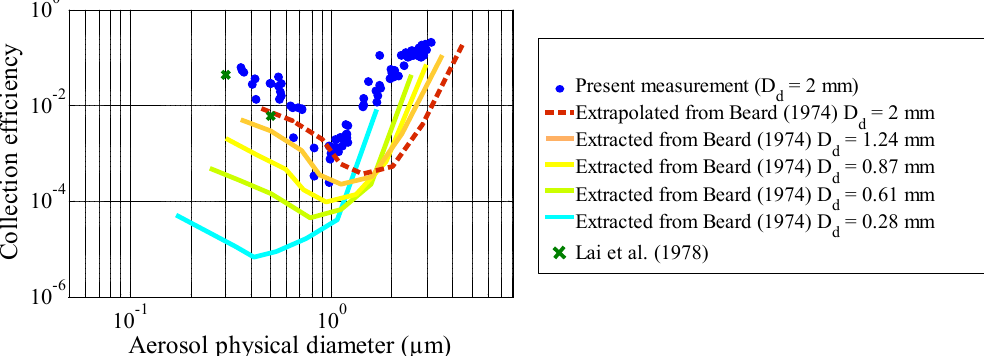
Figure 8. Comparison of present experimental results (blue dots) to the Beard (1974) rear capture model; solid and dashed curves are respectively extracted and extrapolated from Beard (1974).